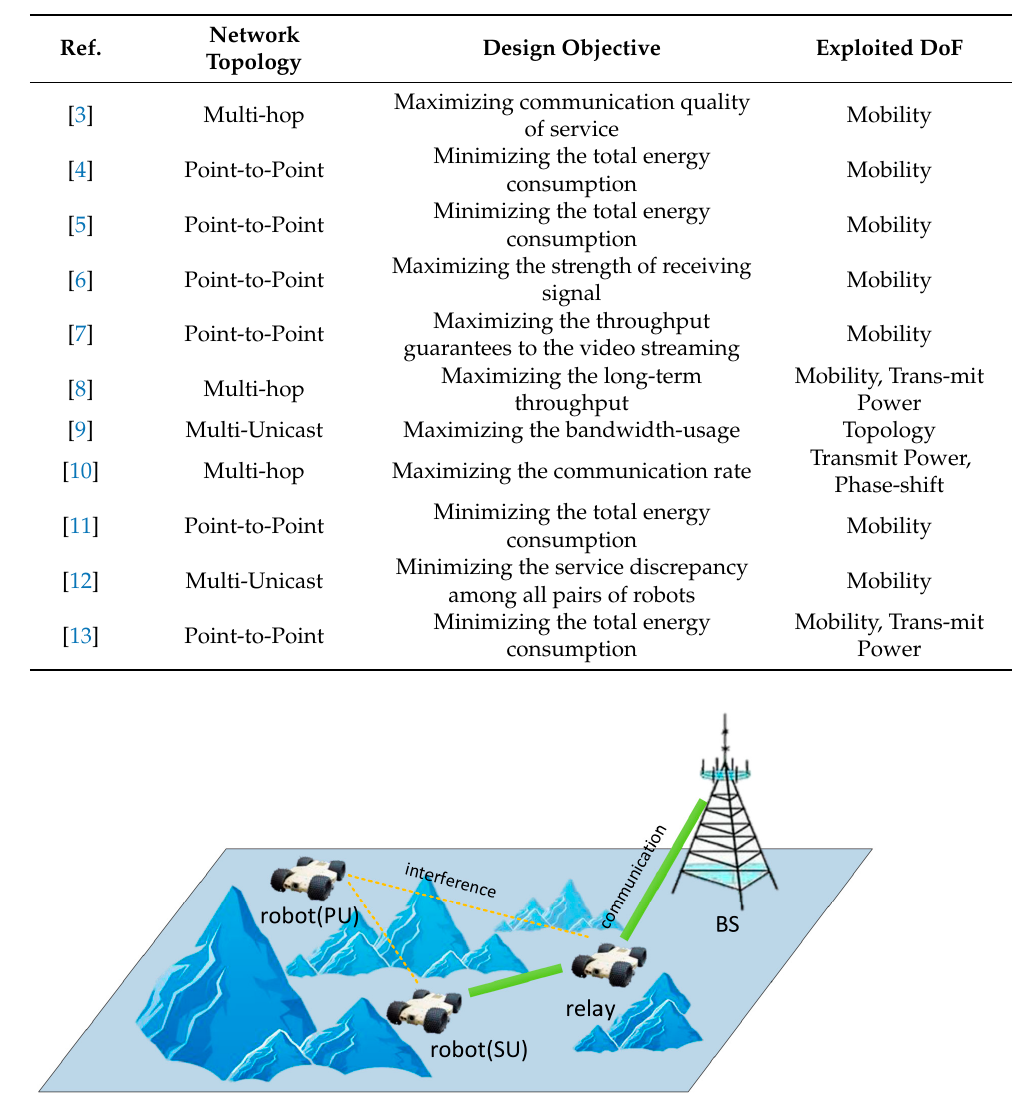
Figure 1. A robot-assisted surveillance scenario. Table 1. Contributions on communication-aware motion planning (CAMP) in networked robotic system (NRS).